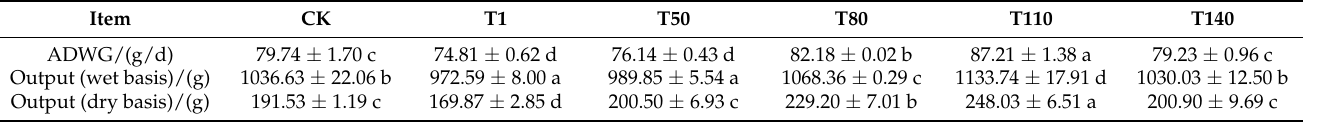
Figure 2. Trend of body width of BSFL. Note: The different lowercase letters indicate significant differences among treatments ( p < 0.05).